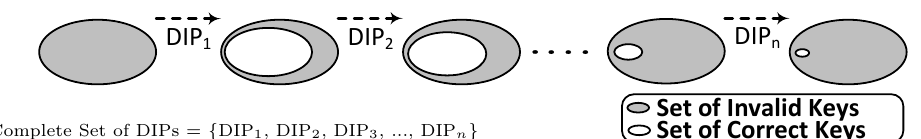
Figure 12: Set of potentially valid keys (the Remaining Keys to be Evaluated) reduces in each iteration of SMT or SAT attack when a new Discriminating Input (DI) is discovered and is added to the Discriminating Input Validation Circuit (DIVC).